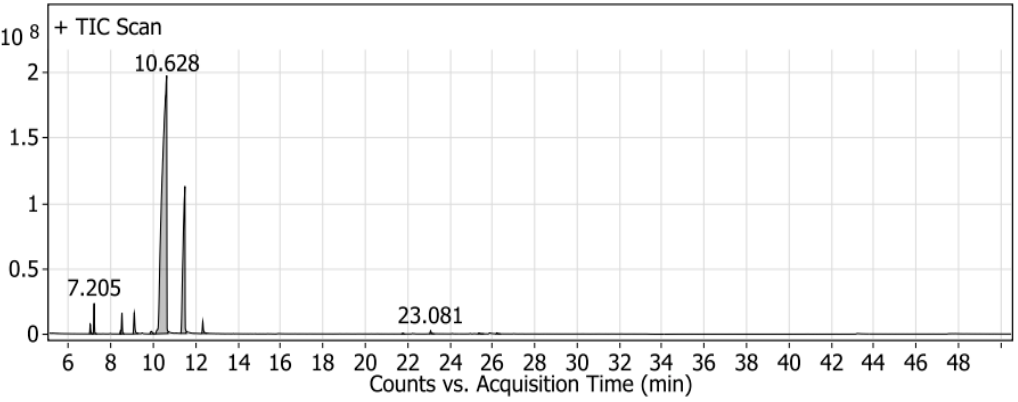
Figure 1. GC/MS chromatogram of mandarin volatile oils. Table 1. Identified volatile compounds by GC/MS spectrometry.